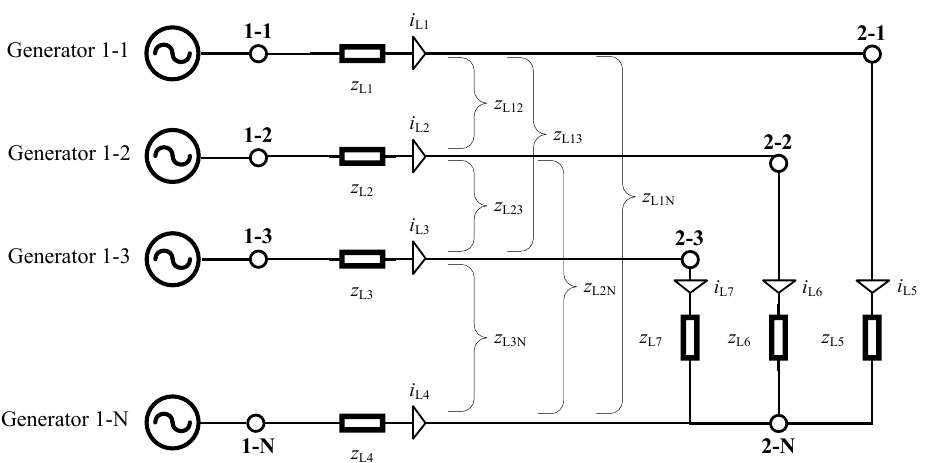
Figure 4. Model of the grid for a three-phase OPF algorithm including mutual